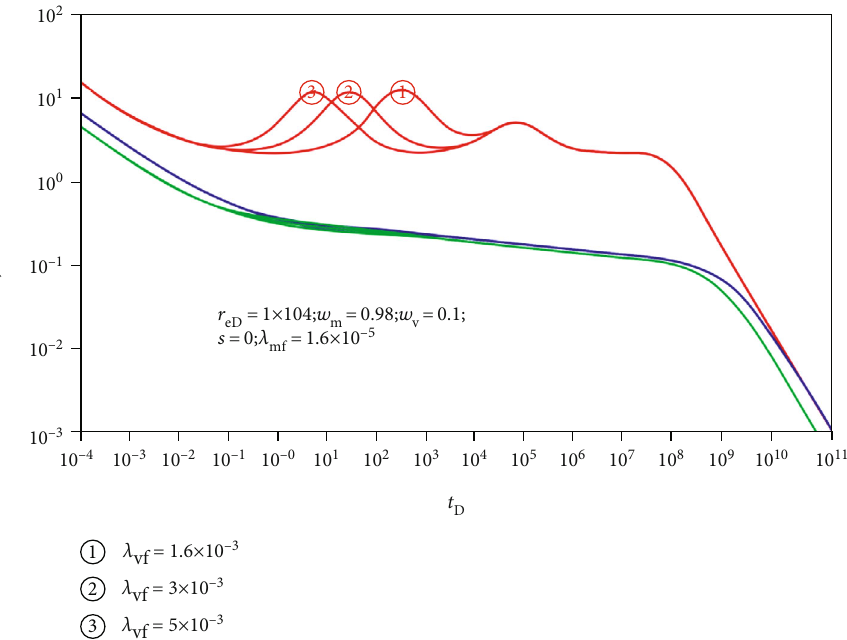
Figure 10: In fl uence of interporosity fl ow of the vug system to the fracture system, λ